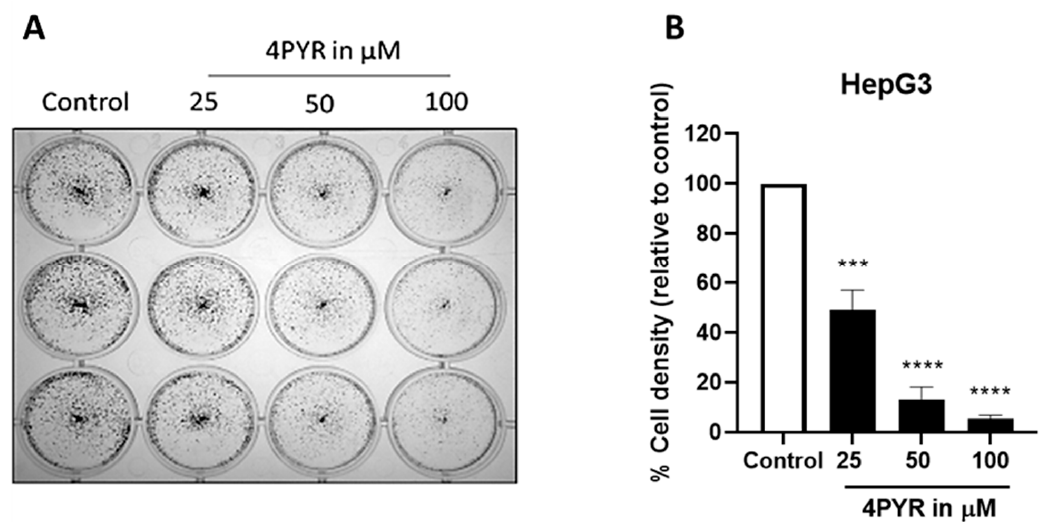
Figure 6. Clonogenic survival of HepG3 cells continuously exposed to 4PYR. HepG3 cells were exposed to 25, 50, and 100 µ M of 4PYR for six days then stained with crystal violet ( A ). Cell density was assessed by measuring the area fraction of the crystal violet-stained cells after 4PYR exposure ( B ). Results are presented as percentage cell density to control ± SEM of three independent experiments. Statistical significance: *** p < 0.001, **** p < 0.0001. Finally, we exposed HEK293T and HepG3 cells to 100 µ M NRH, the reduced form of nicotinamide riboside, for 1, 4, and 24 h and measured the cell extract for the presence of the over-oxidized form of NAD, NADO by LC-MS. While HEK293T did not produce NADO under such conditions, HepG3 cells produced 4NADO intracellularly, and its abundance increased with the length of exposure (Figure